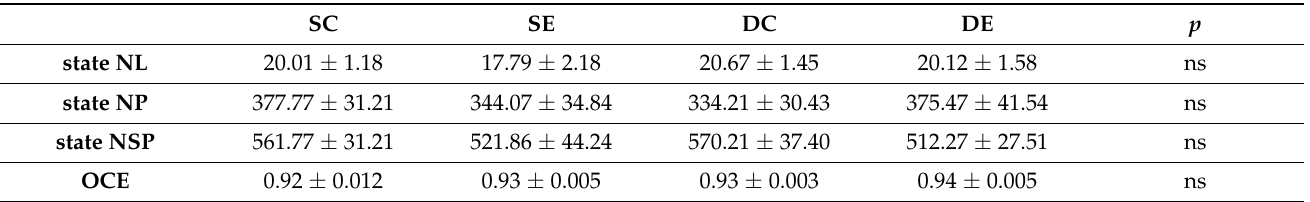
Table 3. The effects of Dex treatment, swimming, and a combination of these factors on skeletal muscle mitochondrial